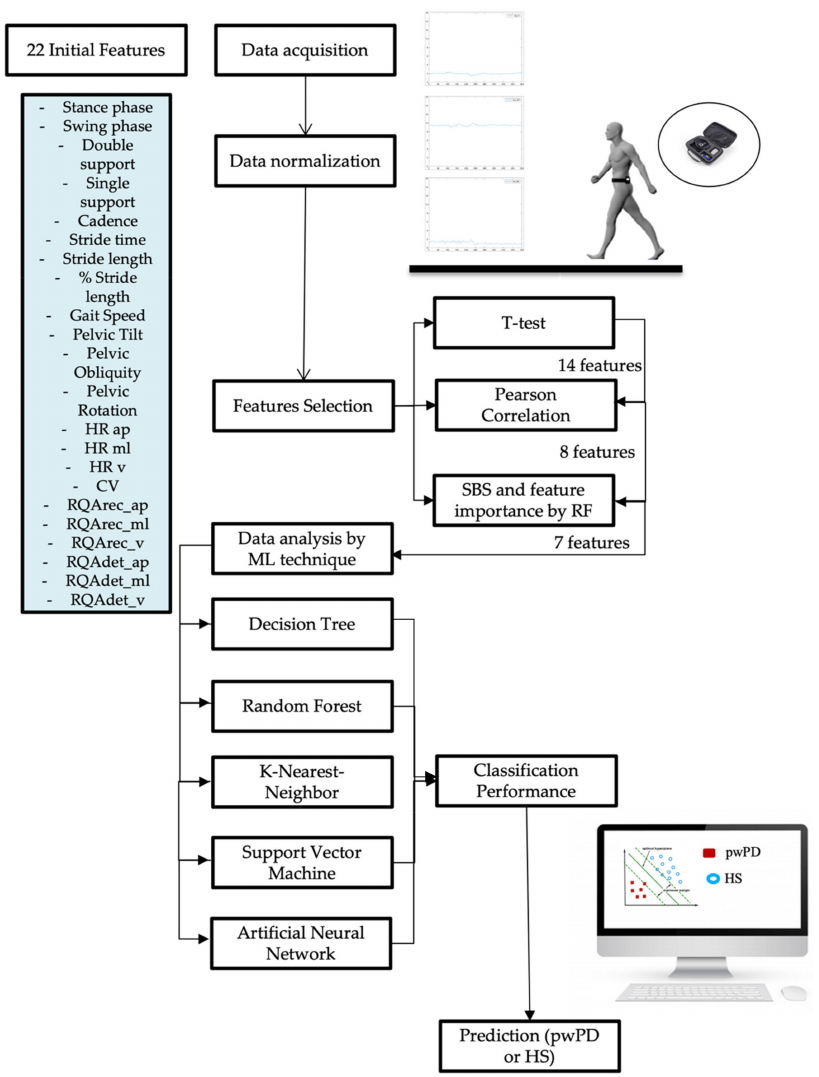
Figure 1. Analysis of our gait prediction flowchart. Description of the Parkinsonian gait prediction flow chart analyzed, including data acquisition, dimensionality reduction, data analysis technique, and gait prediction with classification performance parameter in prediction. First of all, data acquisition by IMU sensor positioned at the trunk level (L5) with the acceleration signals of the trunk in three spatial directions. After normalizing the data, we reduced the number of features from the initial 22 to 7, using the three methods described in feature selection. After this, we implemented five ML algorithms and evaluated their performance in prediction subjects with Parkinson’s from healthy subjects: IMU, inertial measurement unit; ML, machine learning; pwPD, people with Parkinson’s disease; HS, healthy